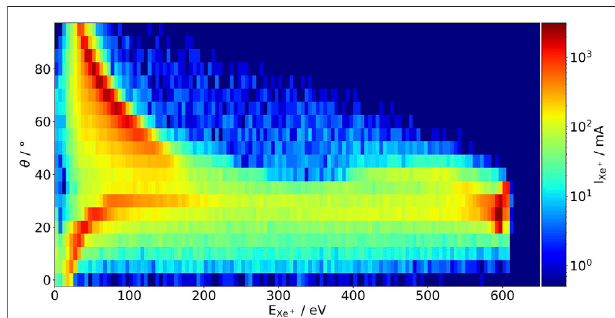
FIGURE 8 | Simulated angular energy distribution of emitted Xe + ions measured at the domain boundary. The angle θ is measured from the symmetry axis to the ray formed by the vertex at the thruster exit at ( r = 0 mm, z = 13.45 mm) to the point where the ion left the domain.